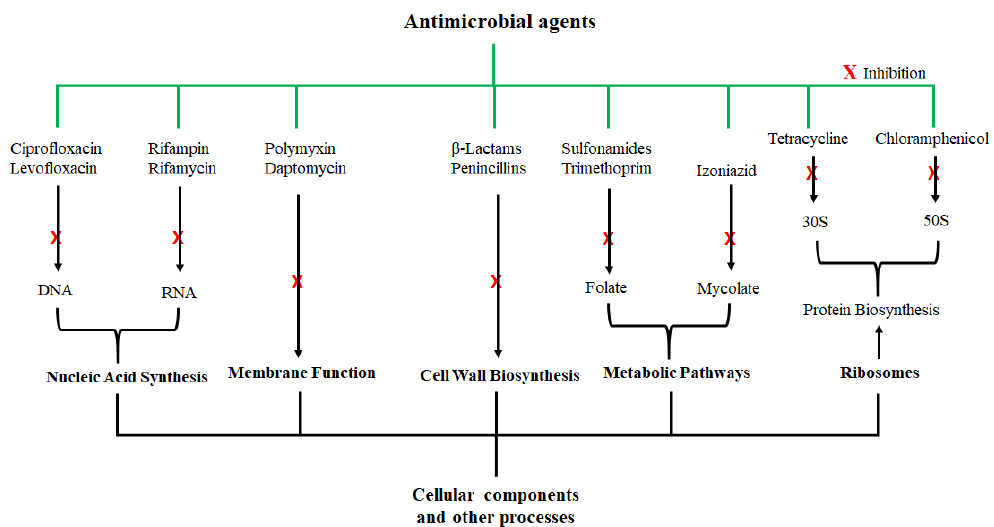
Figure 1. Examples of antimicrobial agents and their modes of action. These compounds are classified according to their cellular or molecular targets.